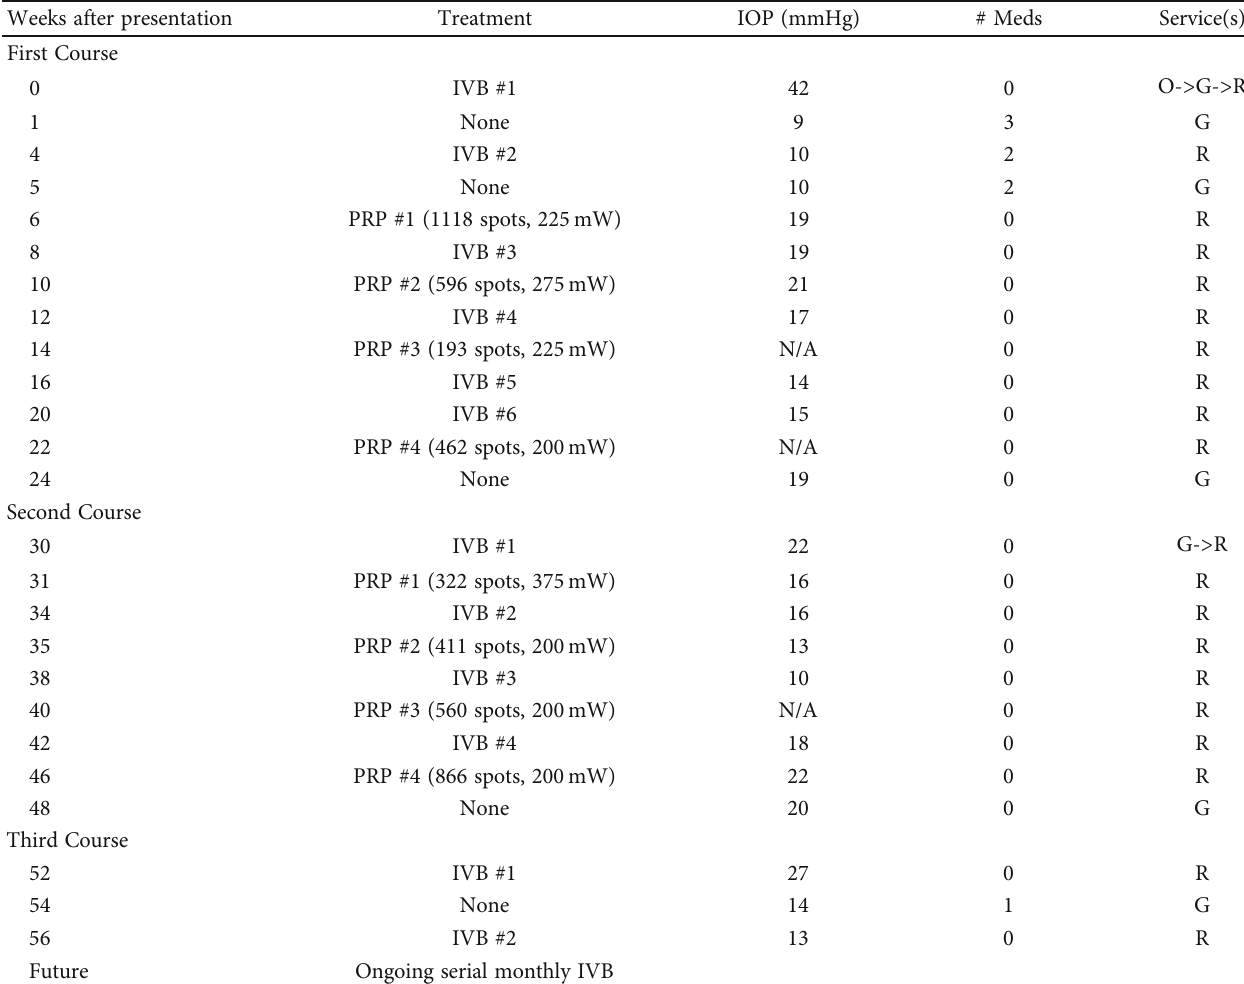
Table 1: Details of antineovascular and intraocular pressure treatment course of the right